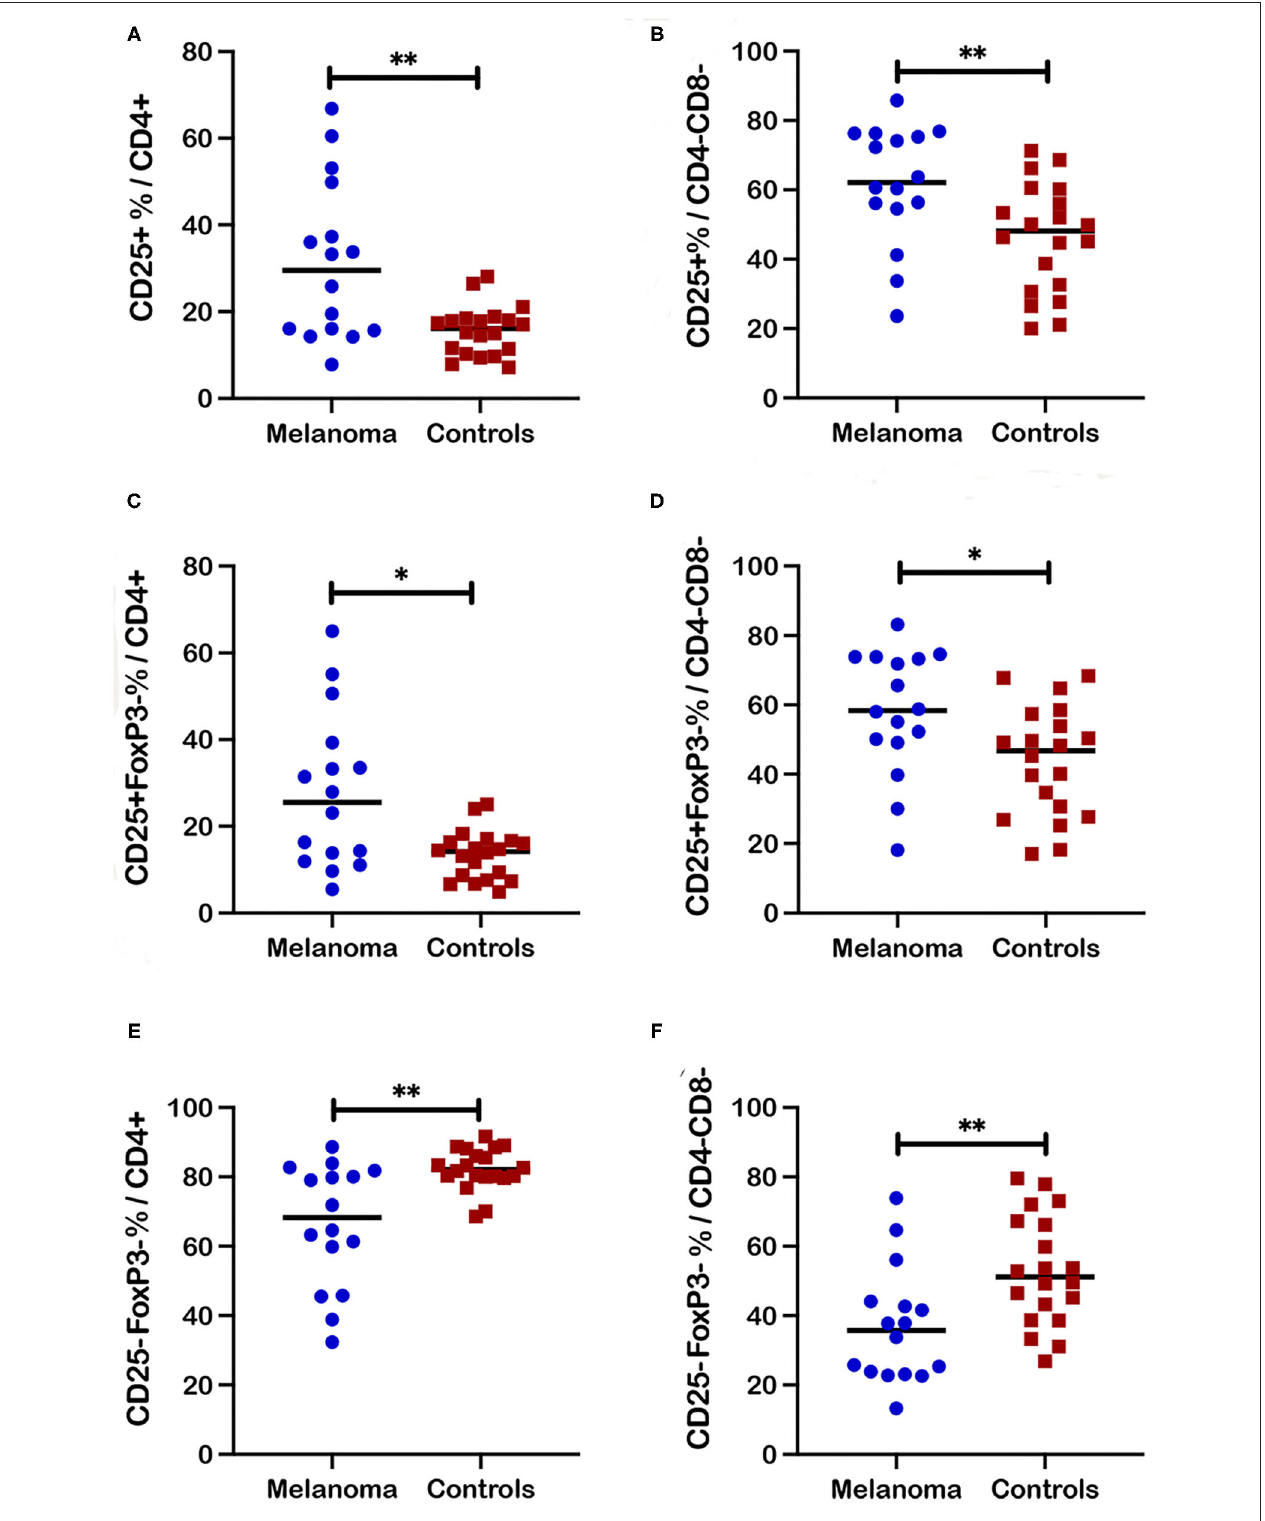
FIGURE 4 | Frequencies of activated and quiescent T cell subsets in blood from canine melanoma patients and healthy controls. Median frequencies of CD25 + cells within the CD4 + (A) and CD4-CD8- (B) T cell subsets are compared between patients and healthy controls. Frequencies of CD25 + FoxP3- cells within the CD4